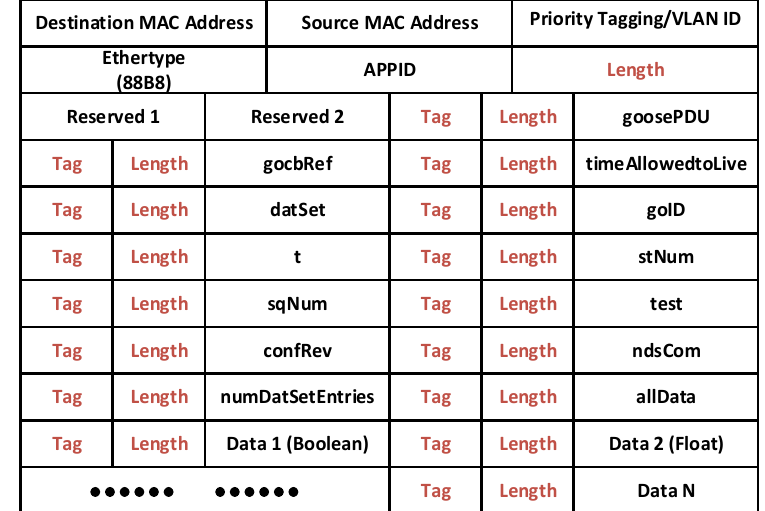
Figure 1. Structure of a Generic Object Oriented Substation Event (GOOSE) Datagram, MAC: media